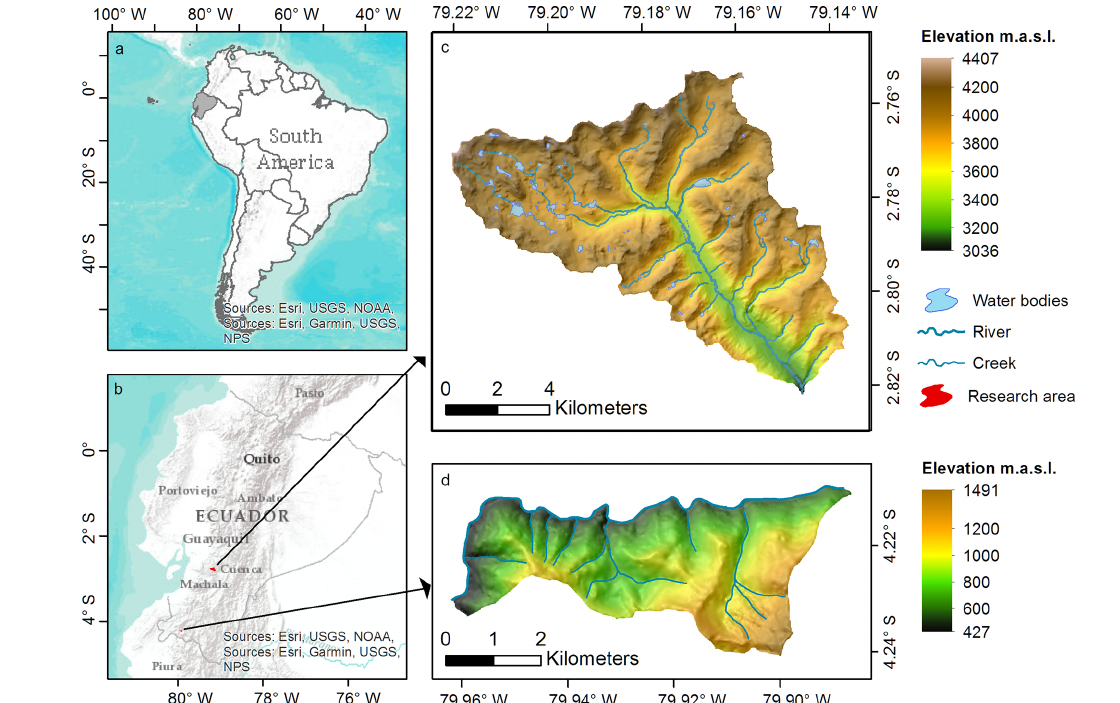
Figure 1. Maps of (a) Ecuador within South America, (b) research areas within Ecuador, (c) Quinuas, and (d) Laipuna (overlaid with hill shading – light source from the north). Adapted from Ließ (2015). Topographical data were used with permission from the Ecuadorian Geo- graphical Institute (2013; national base, scale 1 : 50000), and further GIS data were provided by the NGO Nature and Culture International (NCI) and the municipal public agency